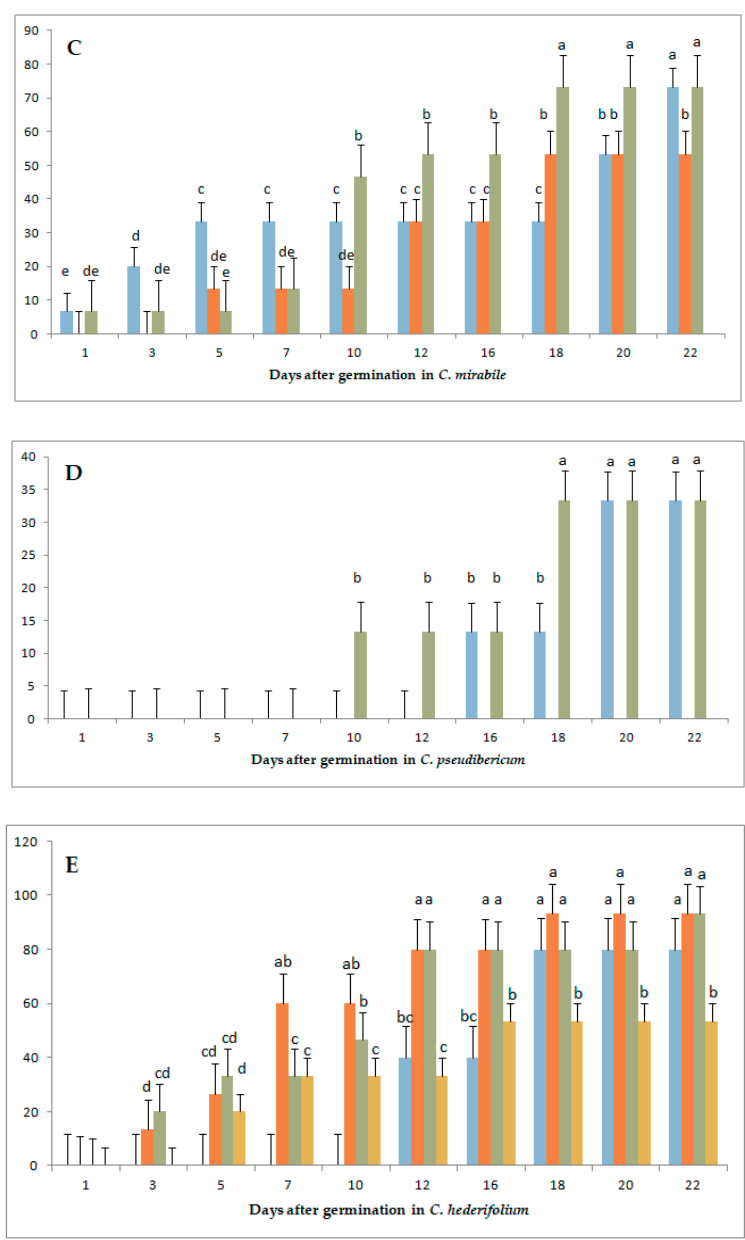
Figure 1. Effect of gibberellic acid (50, 100, and 150 mg/L GA 3 ) and long-day exposure on germination percentage/day ± SE of selected Cyclamen species: ( A ) Cyclamen africanum (African cyclamen); ( B ) Cyclamen cyprium (Cyprus cyclamen); ( C ) Cyclamen mirabile (sowbread); ( D ) Cyclamen pseudibericum (false Iberian cyclamen); ( E ) Cyclamen hederifolium ‘Alba’ (ivy-leaved cyclamen). Values (mean ± SE) followed by different letters are significantly different based on Tukey’s HSD (honestly significant difference) test at p < 0.05.